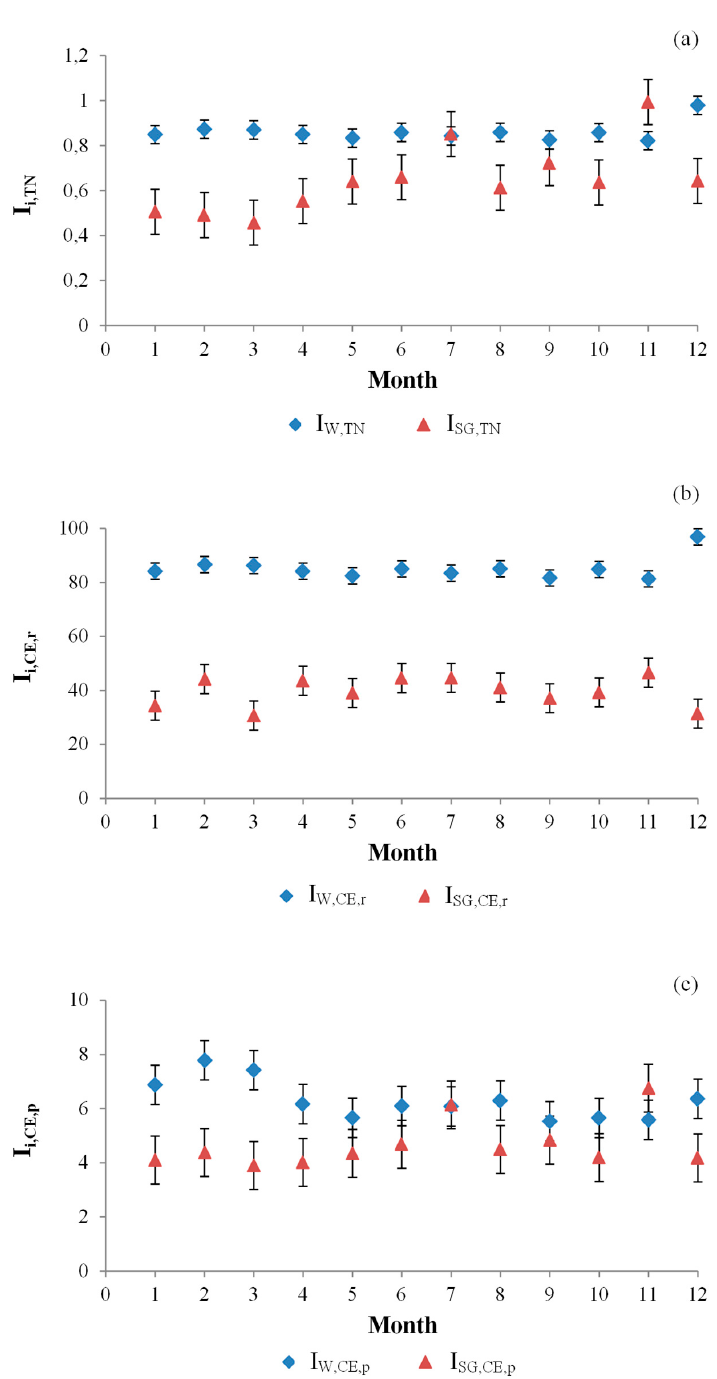
Figure 5. Evolution of indicators of technological nutrient performance (I i,TN ) and indicators of circular economy efficiency (I i,CE,r and I i,CE,p ). ( a ) Indicators of technological nutrient performance for water (I W,TN ) and for sludge (I SG,TN ), ( b ) reductive indicators of circular economy efficiency for water (I W,CE,r ) and for sludge (I SG,CE,r ), ( c ) productive indicators of circular economy efficiency for water (I W,CE,p ) and for sludge (I SG,CE,p ).